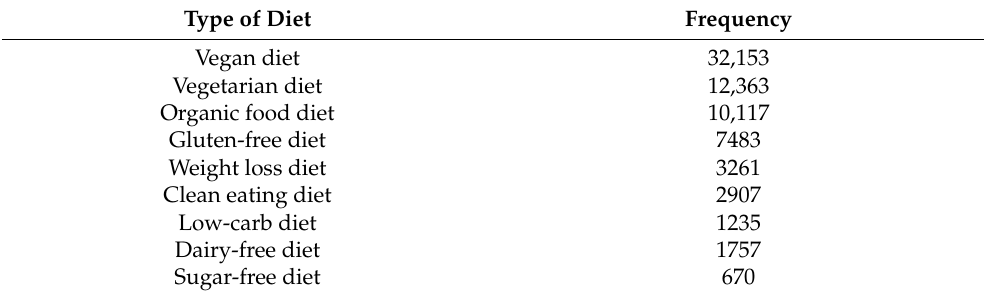
Table 3. Type of diet published in connection with the hashtag #foodblogger on